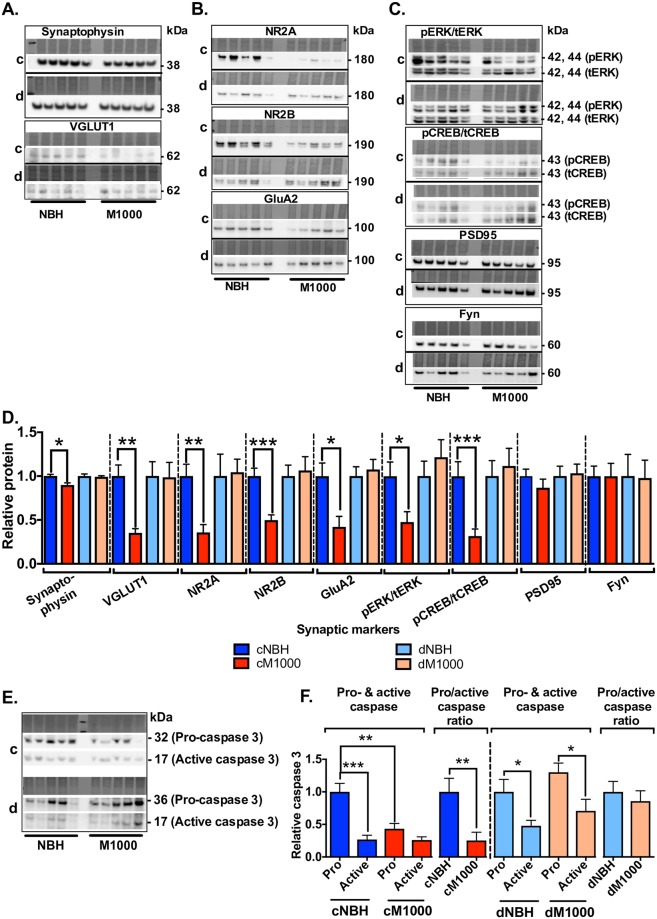
Altered expression levels of key pre- and post-synaptic markers correlate with synaptic dysfunction in WT hippocampi.Following induction of LTP, hippocampi were homogenized and biochemically analysed for key synaptic markers. (A & D) Hippocampi treated with cM1000 [c] expressed reduced levels of pre-synaptic markers, synaptophysin (p = 0.0280) and VGLUT1 (p = 0.0108), relative to those treated with cNBH [c]. Conversely, WT hippocampi treated with dM1000 [d] were associated with unaltered synaptophysin and VGLUT1 levels relative dNBH [d]. (B & D) NR2A/B-containing NMDAR were also reduced in hippocampi treated with cM1000 (NR2A: p = 0.0012; NR2B: p = 0.0003) relative to those treated with cNBH, with unaltered levels when employing dM1000 and dNBH. GluA2-containing AMPAR were also reduced in hippocampi treated with cM1000 relative to those treated with cNBH (p = 0.0077), with unaltered levels when employing dM1000 and dNBH. (C & D) Expression levels of pERK and pCREB were reduced in slices exposed to cM1000 (pERK: p = 0.0339; pCREB: p = 0.0108) relative to cNBH but were unaltered when employing dM1000 and dNBH. PSD95 remained unaltered after exposure to both cM1000 and dM1000 supporting no loss of pre-existing synapses in prion acute synaptotoxicity. Fyn levels remained unaffected after treatment with either cM1000 or dM1000. (E & F) Relative to cNBH, cM1000 reduced expression levels of procaspase 3 (p = 0.0028) with unaltered production of the active form, thereby significantly reducing the pro- to active caspase 3 ratio (p = 0.0083). The pro-caspase 3 expression level was unaltered after treatment with dM1000 compared with dNBH with a normal pro- to active caspase 3 ratio. (A-C, E) Molecular weight markers are provided at right. Data are presented as ± SEM. *p<0.05, **p<0.01, ***p<0.001, ****p<0.0001.